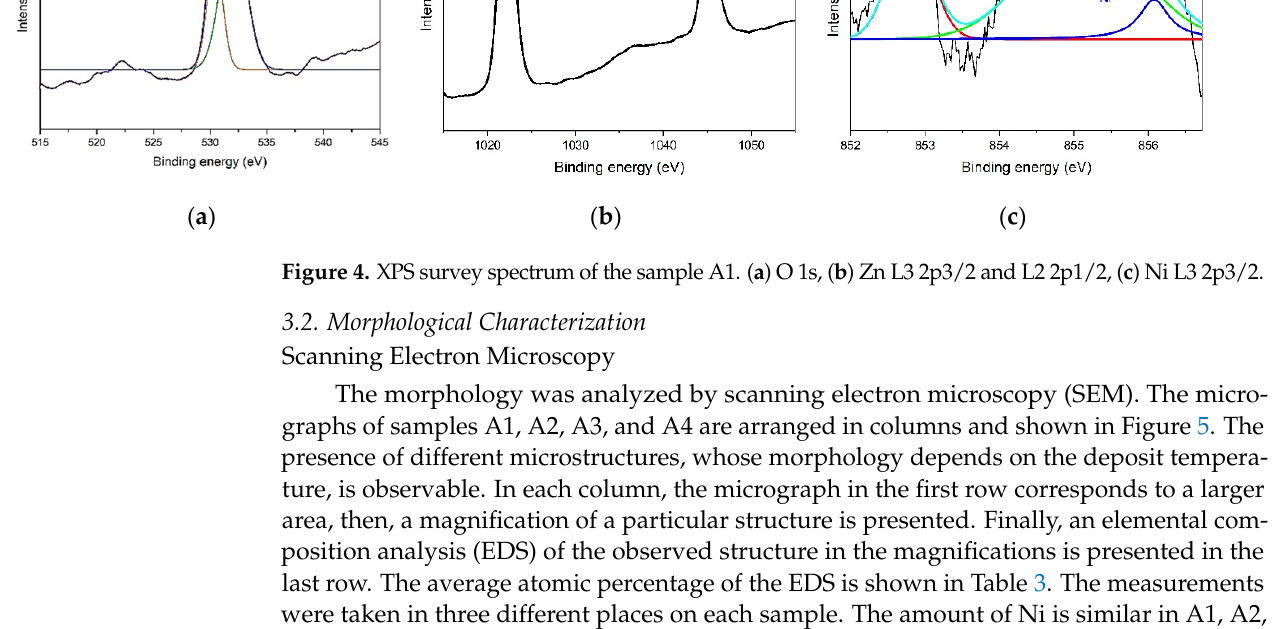
Table 3. Average of the atomic percentage of the elemental composition of the samples. The atomic percentage of Ni decreases as the deposit temperature changes.